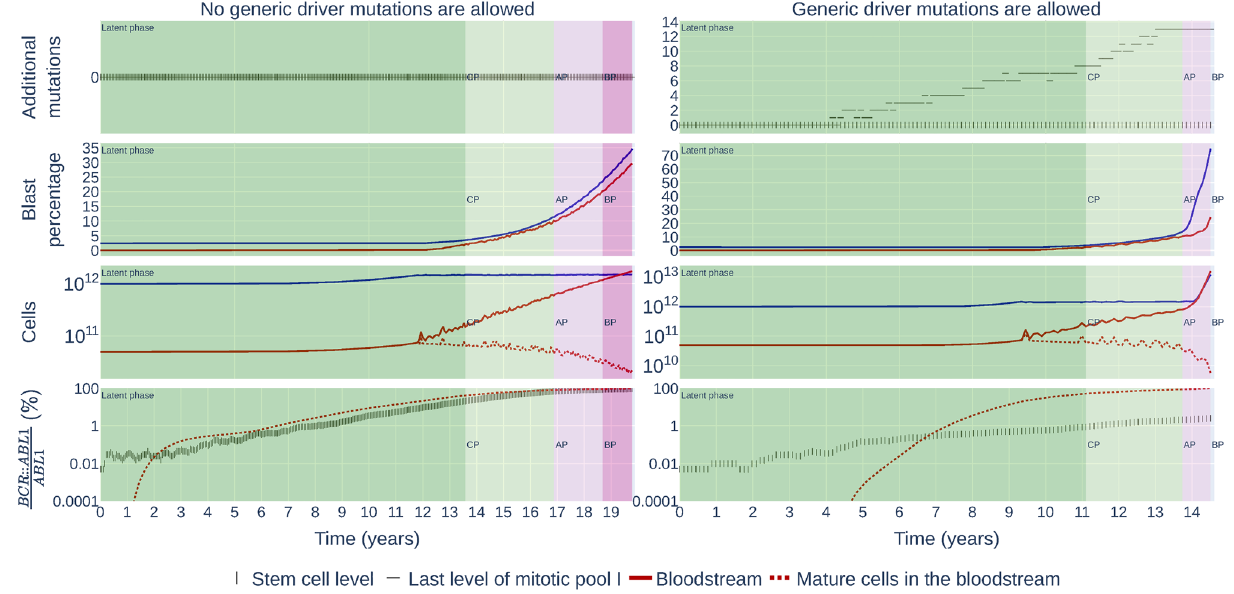
Fig. 1. An accurate model for CML must reproduce this characteristic progression in most individual realiza- tions. In Fig. 3, we show the course of two possible scenarios of CML progression arising from our model. Real-time quantitative polymerase chain reaction can determine the BCR::ABL1 transcript level ( BCR::ABL1 ABL1 ) in the bloodstream. Although the level can exceed 100% (due to many factors, including upregulation of the BCR::ABL1 in leukemic cells 1 or loss of heterozygosity) it can be used to estimate the fraction of BCR::ABL1 positive cells in the bloodstream. Data on the transcript level in CML patients prior to therapy exhibit a wide range of values from 50% to above 100% with an average close to 100% 1 . The left column of Fig. 3 shows a simulation where only the BCR::ABL1 cell clone and the healthy cells are present, while the right column shows the case where additional driver mutations are present. In the first row, we depict the maximum number of additional mutations in a cell at two decisive levels in the hierarchy: the HSCs level and the last level of mitotic pool I. In the right column (where additional mutations occur), the maximum number of additional mutations in the last level of mitotic pool I increase rapidly up to 8 at the beginning of the chronic phase reaching 13 by the end of the chronic phase. At the stem cell level, however, no additional mutations arise. In the second row, we show the blast percentage in the bone marrow and the bloodstream. For both pro- gression modes, the growth of the blast percentage accelerates with time, but there is a noticeable difference at the beginning of the accelerated phase. Due to the accumulation of the additional driver mutations, the blast percentage increases more sharply, thus, shortening the duration of the accelerated and blast phases. In the third row, both simulation modes show an increase in the total number of cells and a decrease in mature cells in the bloodstream. In the right column, we can also appreciate a sharp rise in cell numbers due to the increased cellularity produced by the self-sustainable cell group with driver mutations. In the fourth row, we show the BCR::ABL1 / ABL1 transcript levels for both modes of CML progression. These levels exhibit a sharp increase after a few years from the introduction of the HSC carrying the BCR::ABL1 gene. The leukemic cells take over and displace the healthy cells in the bone marrow over the course of the disease. An interesting observation is that if additional driver mutations are present (implying that HSCs are slower than in the left column, as explained later), then the HSC compartment still contains mainly healthy cells.